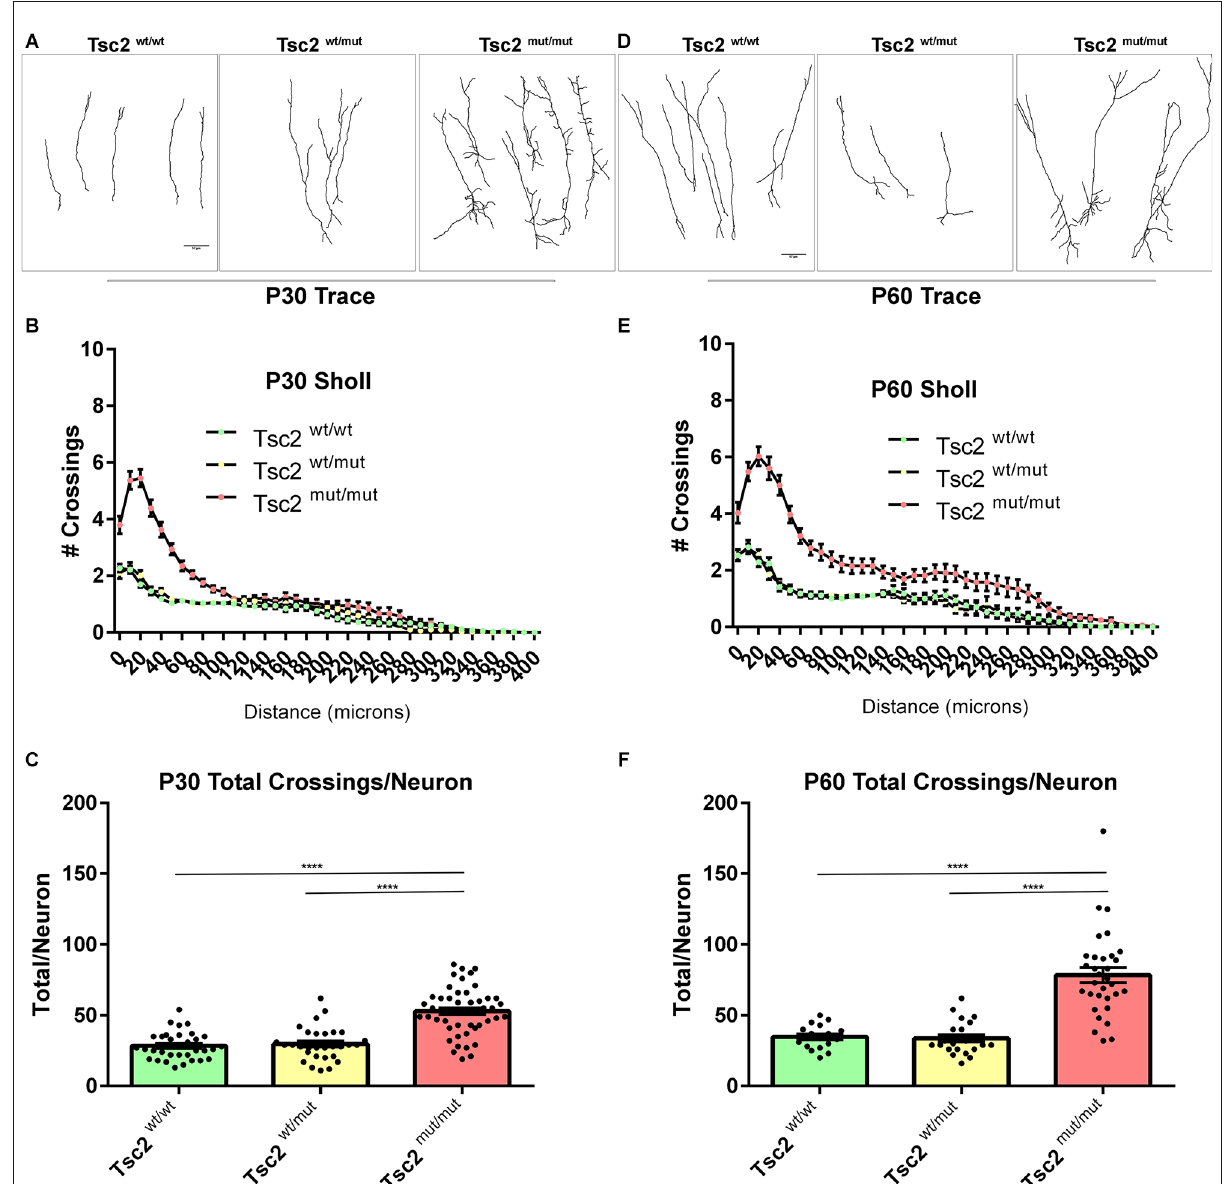
FIGURE6 Neuron dendrite morphology is altered by loss of Tsc2. (A) P30 traces of OB GC dendrite arbors. (B) Quantification of the number of dendrite crossings of concentric circles drawn in relation to distance at P30, also known as sholl analysis. (C) Quantification of the total number of dendrite crossings per neuron at P30. (D) P60 traces of OB GC dendrite arbors. (E) Quantification of the number of dendrite crossings of concentric circles drawn in relation to distance at P60, also known as sholl analysis. (F) Quantification of the total number of dendrite crossings per neuron at P60. **** p <